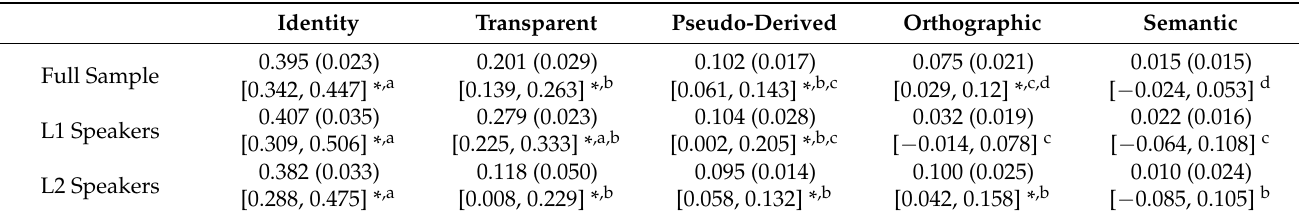
Table 1. Mean g (SE) [95%CI] for the Prime-Type Relationship for the Full Sample, for Studies with L1 Speakers and with L2 Speakers.